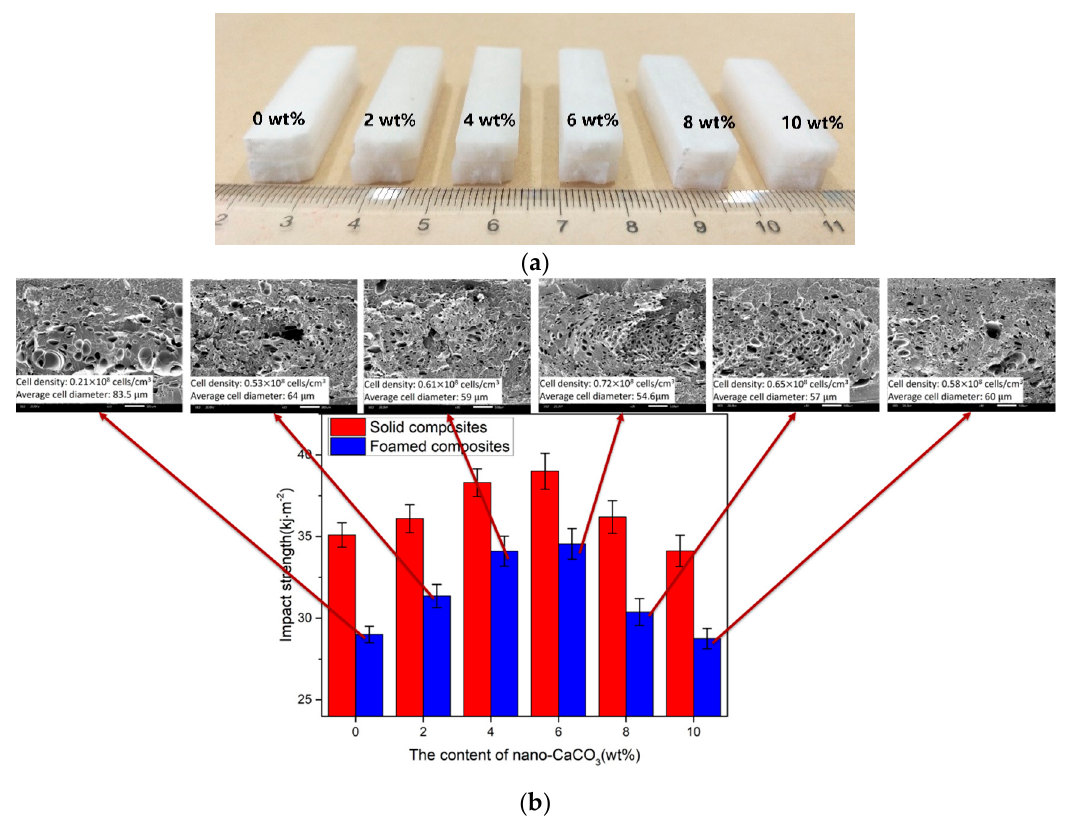
Figure 8. The results of the izod impact tests: ( a ) the samples after impact tests; ( b ) the impact strength.